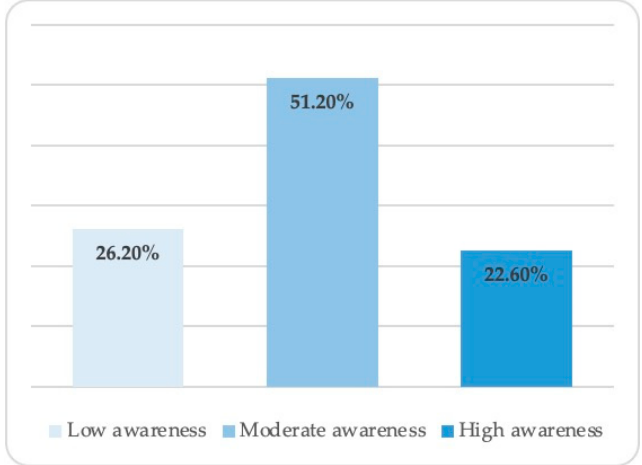
Figure 2. Orthodontic awareness levels among participating parents (N = 473). Demographic differences in parents’ awareness levels are demonstrated in Table 3. Table 3. Demographic differences in parents’ awareness of malocclusion and orthodontic consultation for their